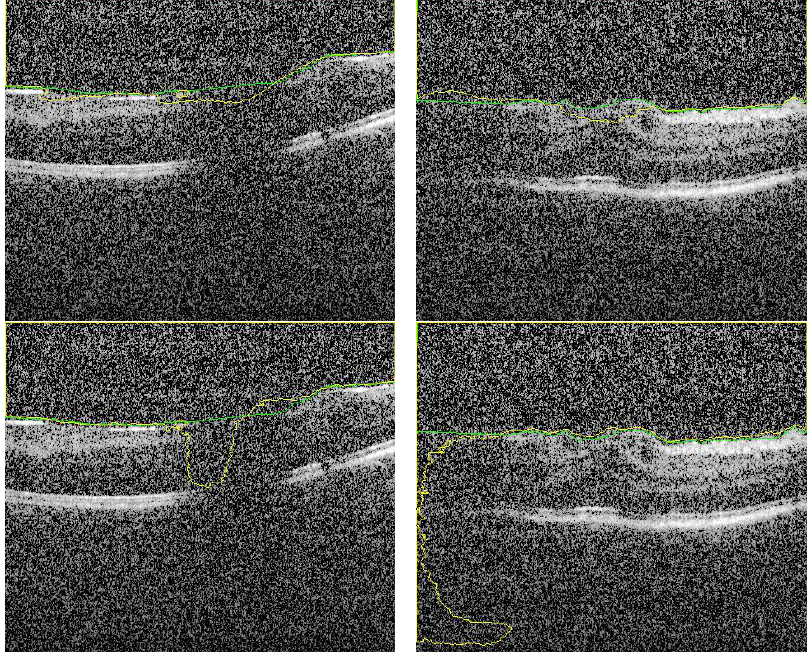
Figure 6. Sample of segmented images of our proposed approach (first row) compared with previous results using only U-Net [16] (second row). The green and yellow colors represents the ground truth and the CNN-segmented